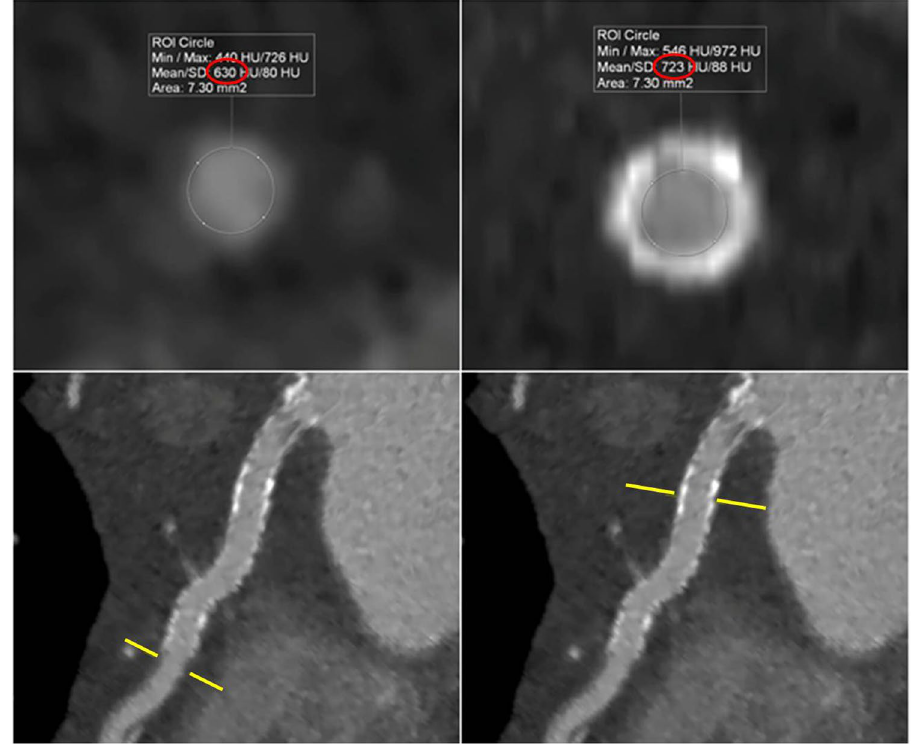
Figure 3. Calculation of stent-lumen attenuation increase ratio (SAIR). SAIR was calculated using the following equation: stent lumen attenuation increase ratio = (in-stent attenuation − coronary lumen attenuation)/coronary lumen attenuation. Example of coronary lumen attenuation (630 HU) as well as in-stent lumen attenuation (723 HU) measured in a sinogram affirmed iterative reconstruction series. SAIR = (723 − 630)HU/630 HU =